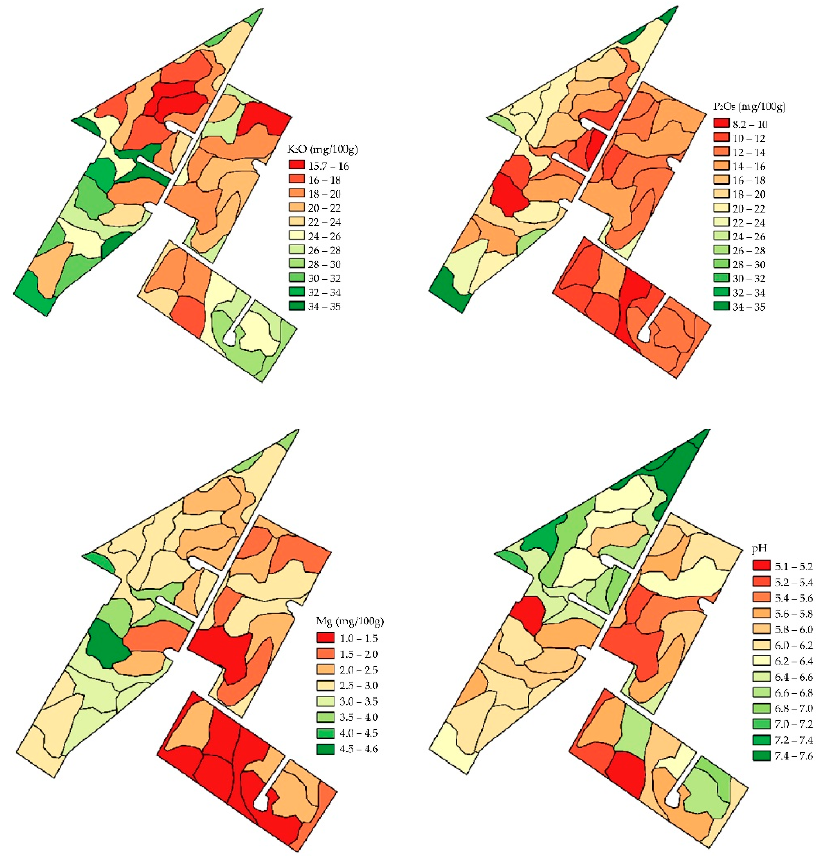
Figure 2. Nutrient content in soil and pH in study area.